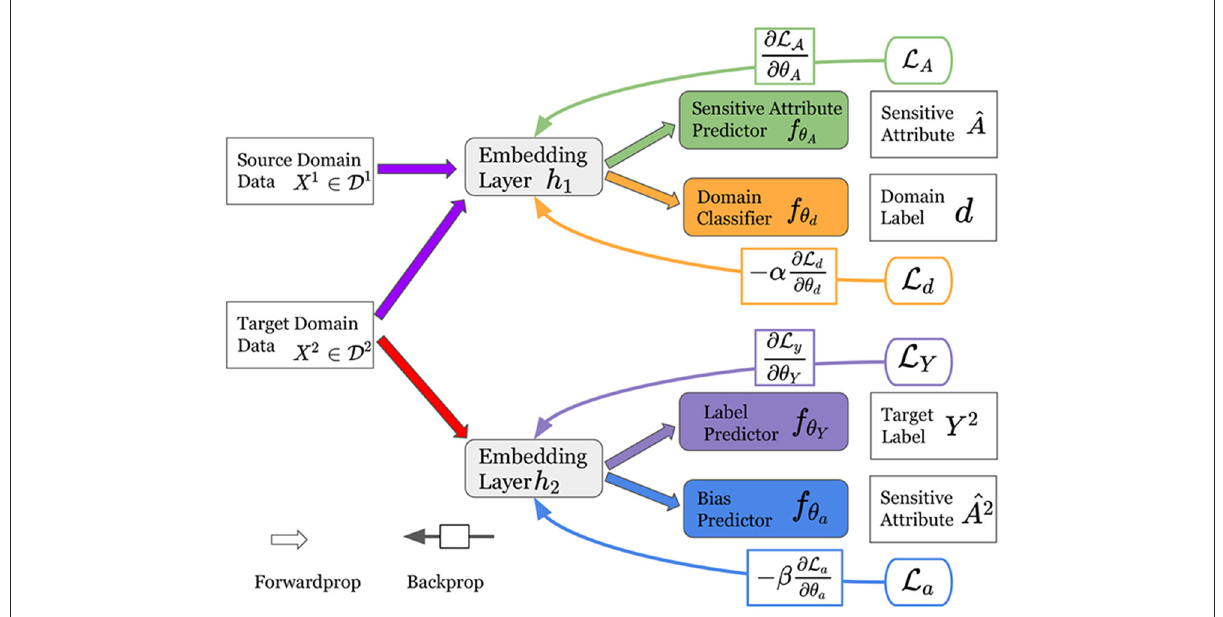
FIGURE2 An illustration of the proposed framework F AIR DA. It consists of two major modules: (1) an adversarial domain adaptation module containing a sensitive attribute predictor and a domain classifier; and (2) an adversarial debiasing module consisting of a label predictor and a bias